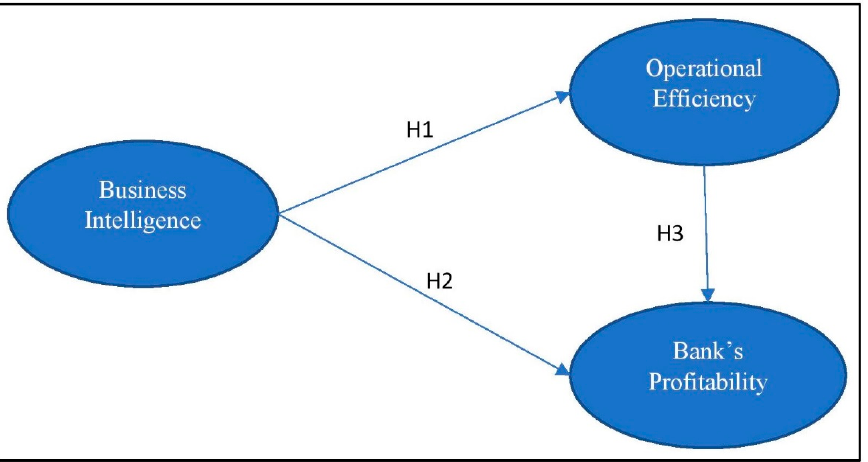
Figure 1. Conceptual model with hypothesis developed by the author.